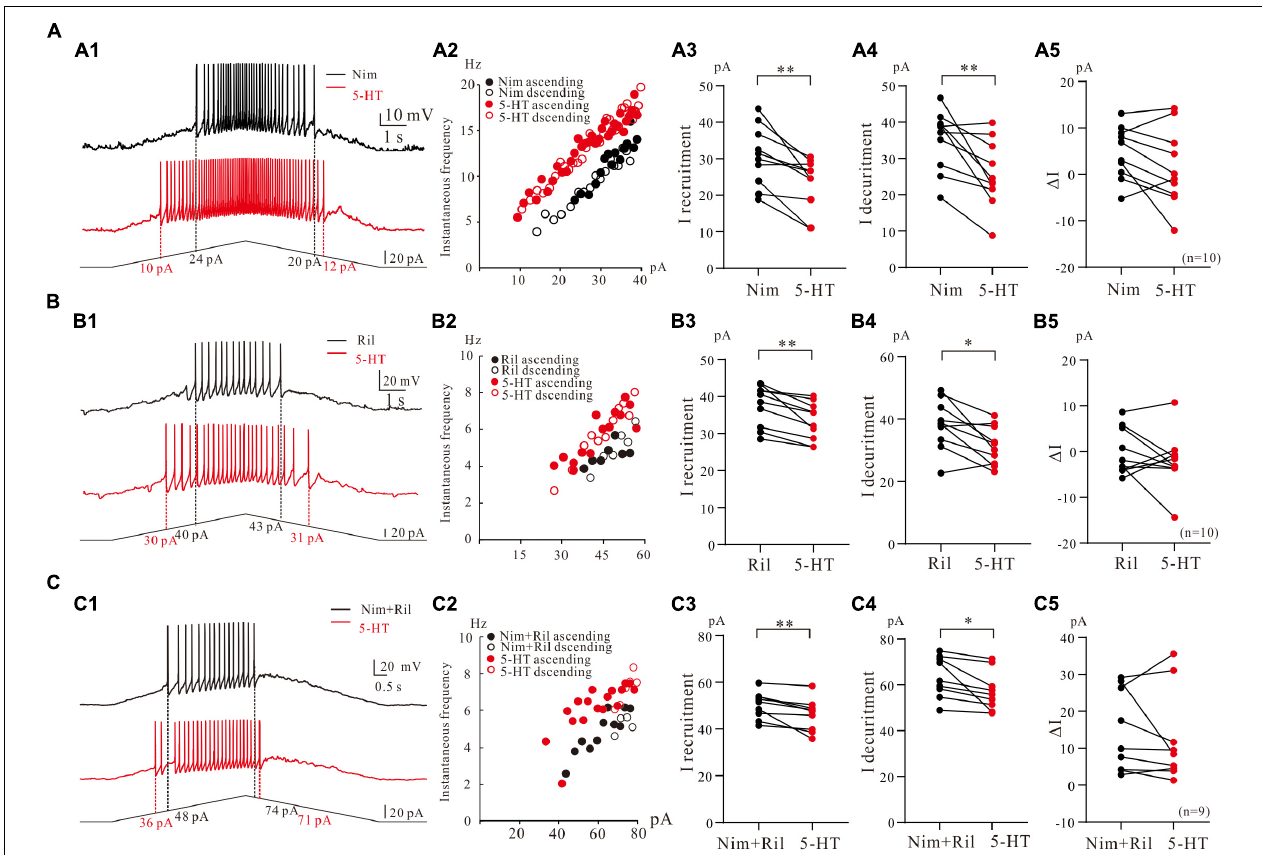
FIGURE 7 | The effect of 5-HT on repetitive firing properties of 5-HT neurons with regulation of Na_PIC + TDR_PIC, Ca_PIC + TDR_PIC, and TDR_PIC. (A1–C1) Repetitive firing with regulation of Na_PIC + TDR_PIC, Ca_PIC + TDR_PIC, and TDR_PIC, respectively (black). Ten micrometers 5-HT was then applied to the recording solution (red). (A2–C2) Instantaneous firing frequency/current relationship recorded for control (black) and 5-HT (red). (A3–C3) Recruitment current measured for control (black) and 5-HT (red); (A4–C4) Decruitment current measured for control (black) and 5-HT (red). (A5–C5) (cid:49) I calculated for control (black) and 5-HT (red). Error bars were shown as SD. ∗ P < 0.05, ∗∗ P < 0.01, paired t